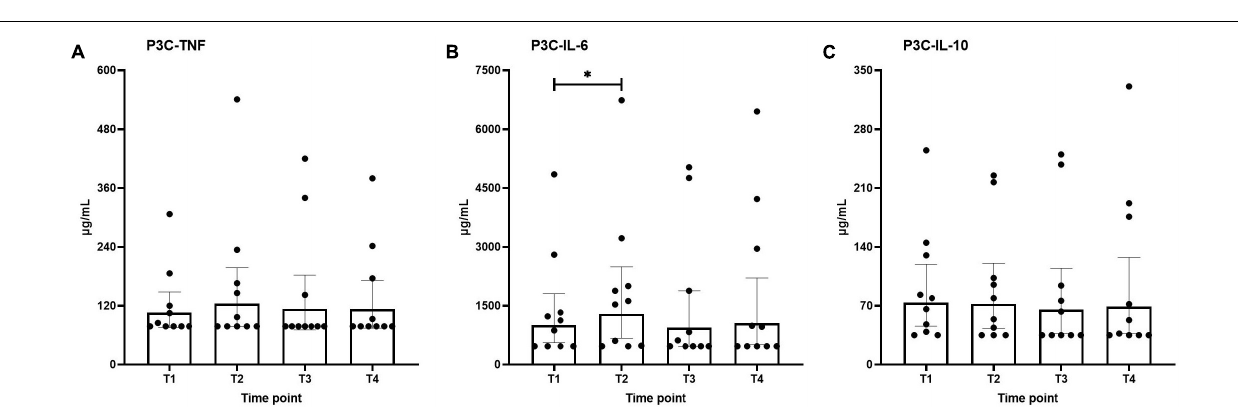
FIGURE 5 | Production of TNF (A) , IL-6 (B) , and IL-10 (C) following ex vivo stimulation of leukocytes with Pam3Cys (P3C). Data are represented as scatter plots with bars indicating geometric mean and whiskers representing 95% confidence interval (CI). ∗ p < 0.05 vs.